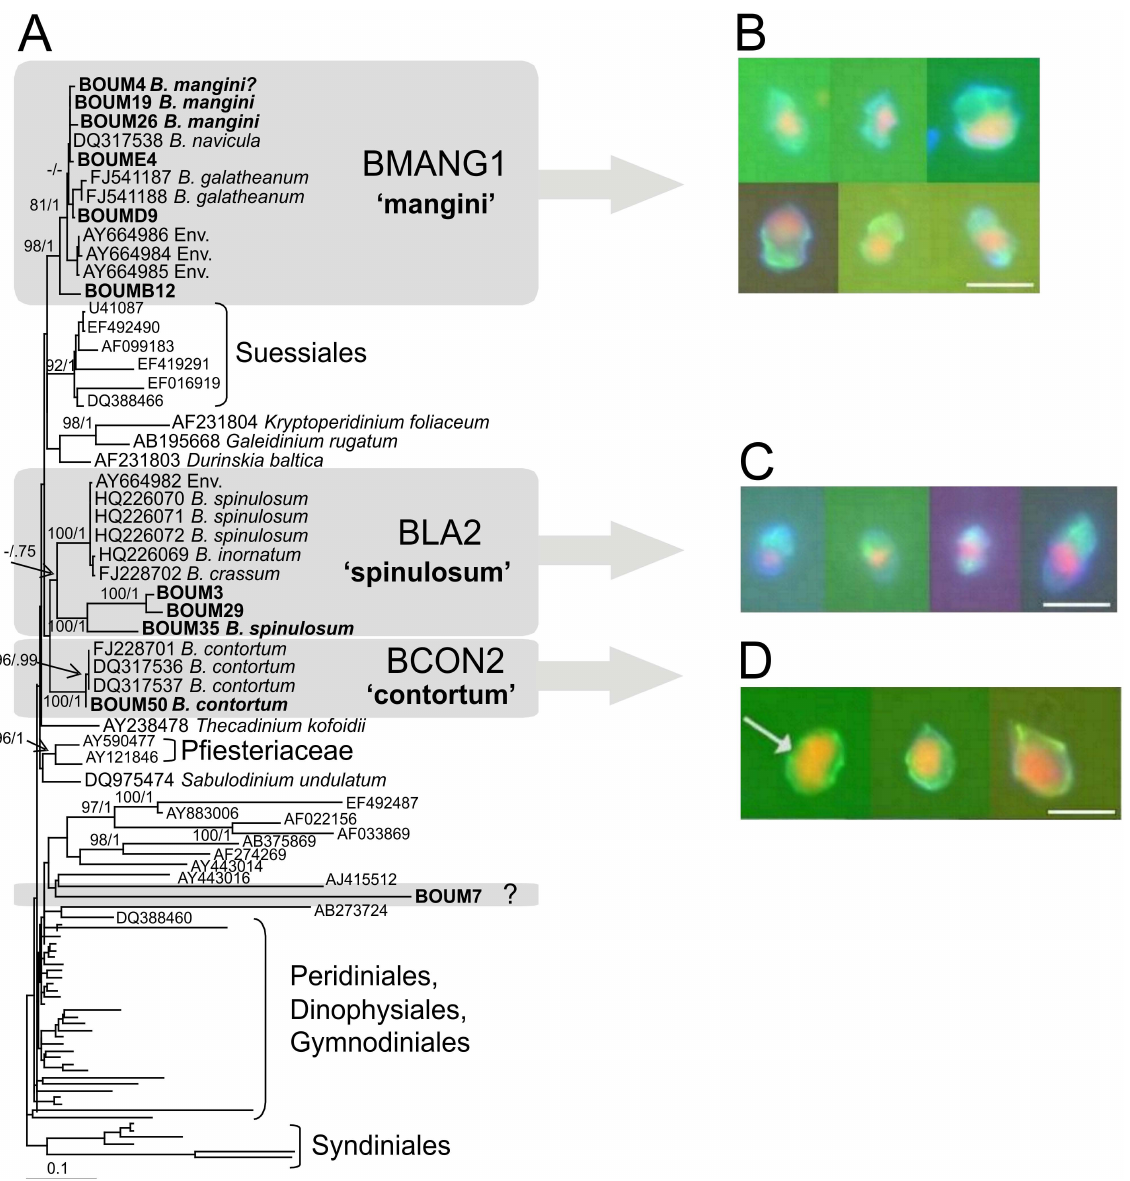
Fig. 5. Phylogeny of Blastodinium spp. and detection of dinospores by fluorescent in situ hybridization. (A) Maximum likelihood analyses of SSU rDNA gene sequences of Blastodinium spp. Sequences obtained in this study are in bold. Complete list of sequences available in Supplement (Table S1). Maximum likelihood bootstrap values (higher than 70%) and posterior probabilities of Bayesian inferences (higher than 0.7) are reported at the nodes of the principal clusters, respectively. Scale bar corresponds to 0.1% divergence. (B) Blastodinium dinospores observed in BOUM samples using the probe BMANG1, specific for the “mangini” cluster. (C) Blastodinium dinospores observed in BOUM samples using the probe BLA2, specific for the “spinulosum” cluster. (D) Blastodinium dinospores observed in BOUM samples using the probe BCON2, specific for the “contortum” cluster. Scale